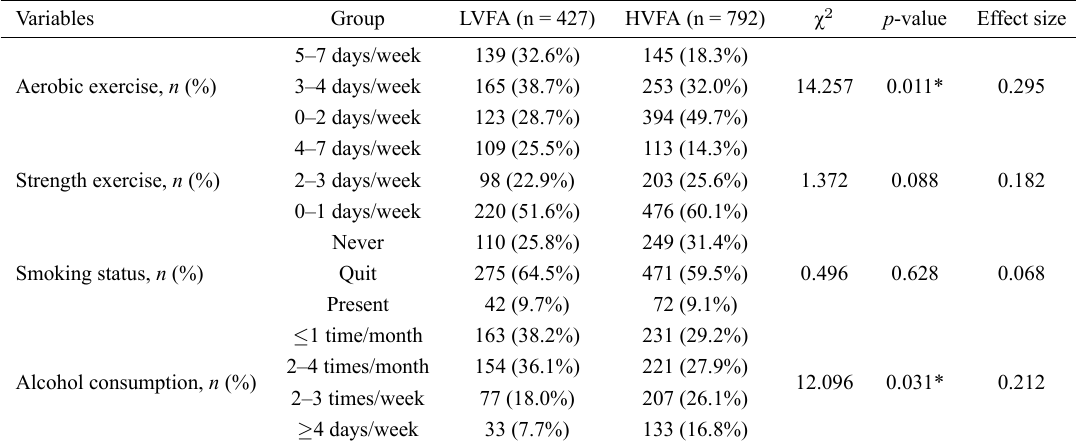
Table 2. Low VFA and high VFA ratio of categorized